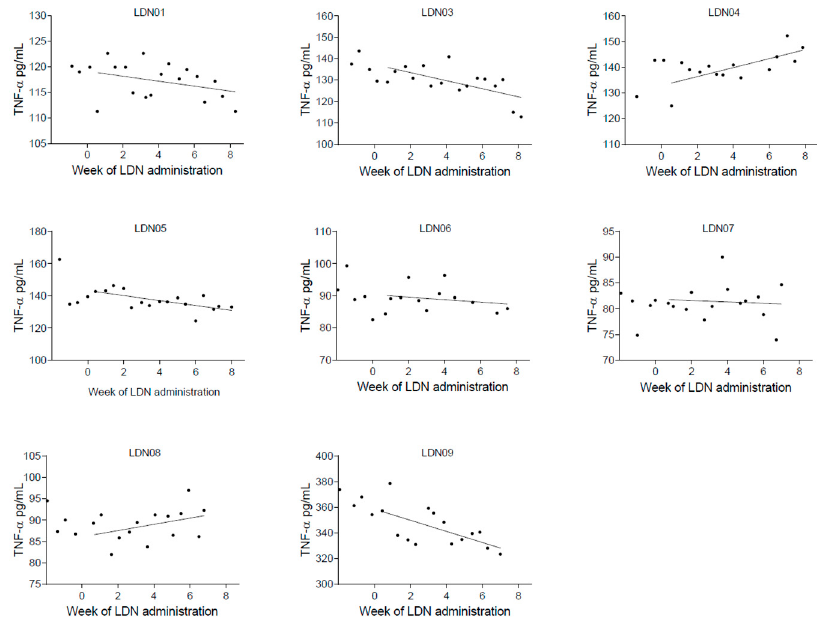
Figure 2. The plasma concentrations of TNF- α measured in samples obtained from each participant during the study. On the y -axis, the concentration is shown in pg/mL. On the x -axis, time is shown in weeks with zero signifying the commencement of LDN administration. A linear regression line is fitted to the 0–8 week time period.